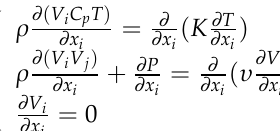
Figure 4. Isothermal battery calorimeter assembly [18].